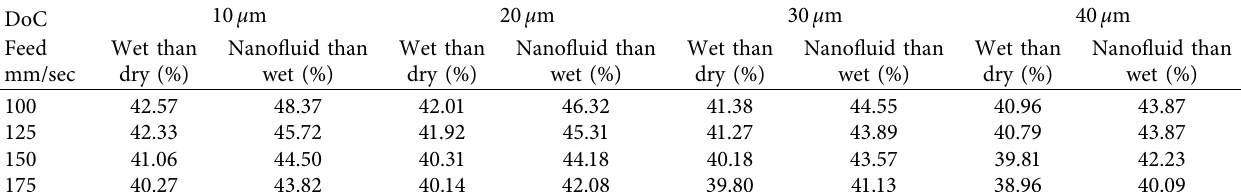
Table 8: Temperature reduction by coolant and lubricant at constant